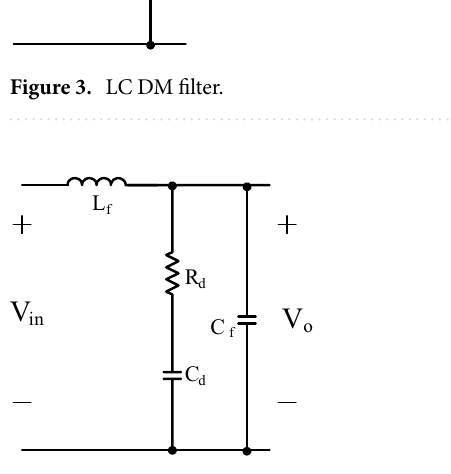
Figure 4. LC with damping DM